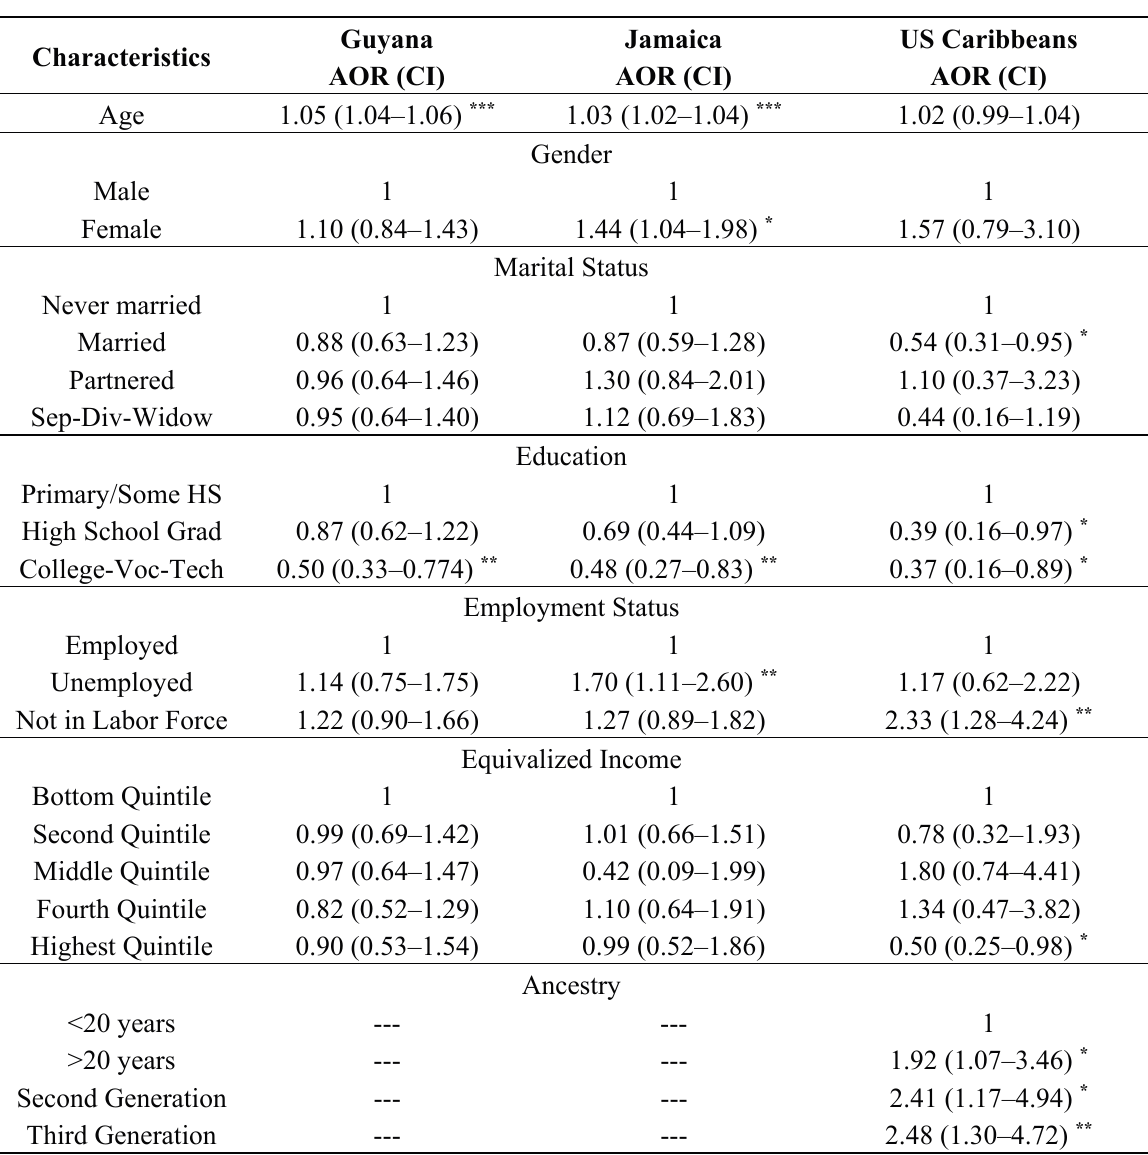
Table 10. Factors associated with self-rated general health (fair/poor) by